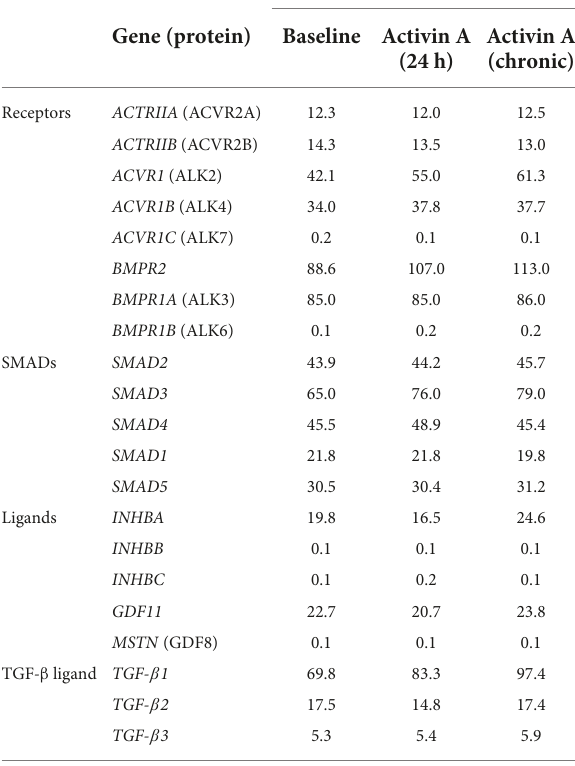
TABLE 1 Effect of Activin A on expression of genes involved in activin